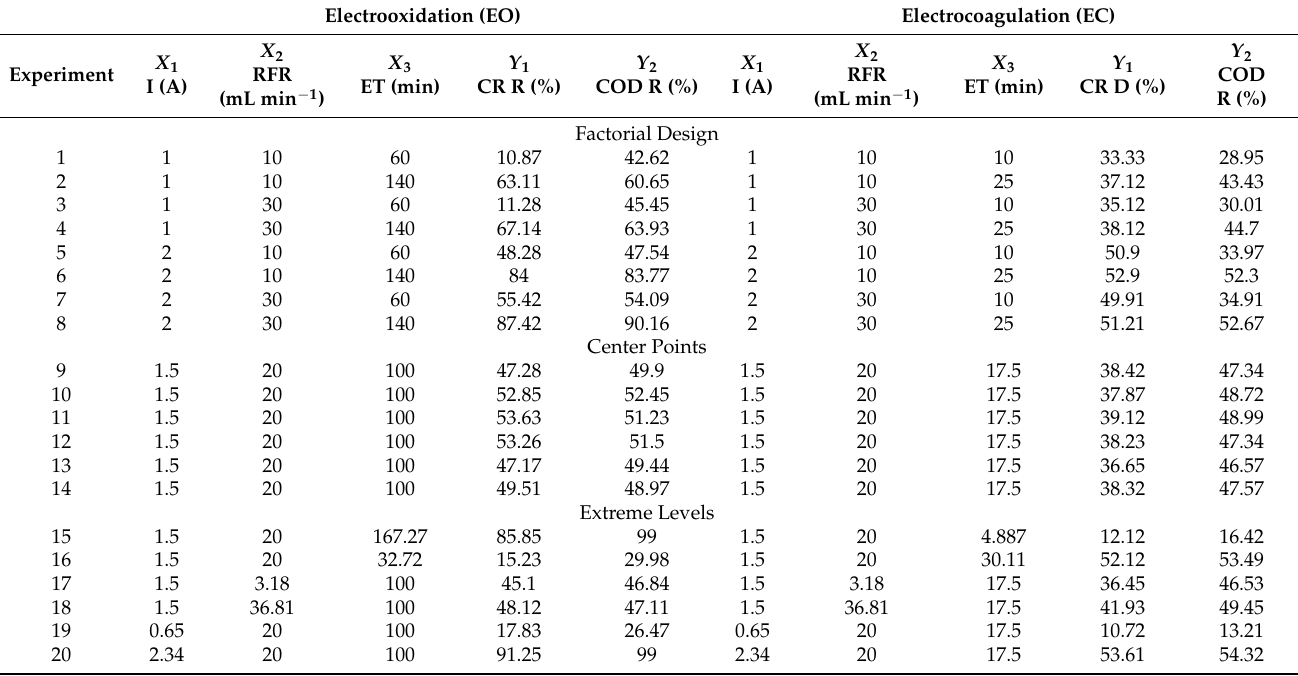
Table 2. Experimental levels and factorial 2 2 and central composite matrix for EO and EC. Electrooxidation